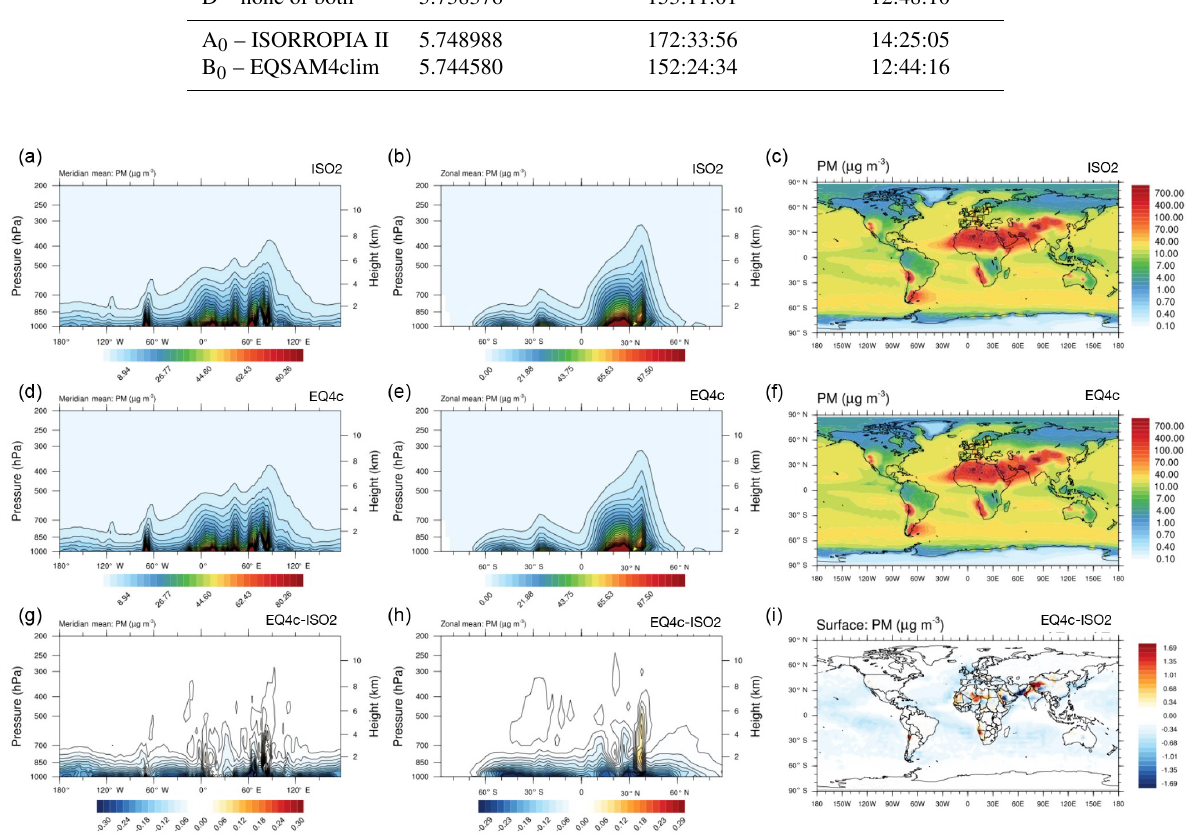
Figure 7. Global aerosol distributions of the total (liquids and solids) particulate matter: meridional mean (a, d, g) , zonal mean (b, e, h) , and atmospheric burden (c, f, i) . The EMAC results shown are based on ISORROPIA II (ISO2, a, b, c ), EQSAM4clim (EQ4c, d, e, f ), and the corresponding difference between both simulations (EQ4c minus ISO2, g, h, i